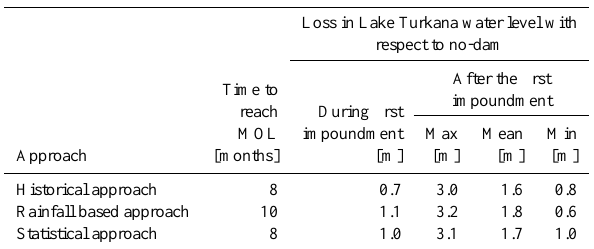
Table 5. Comparison of results from the three approaches used for the hydrologic assessment of the Gibe III